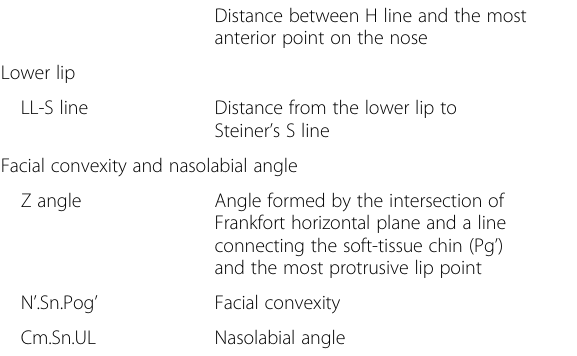
Table 1 Skeletal, dental and soft tissue cephalometric variables Maxillary skeletal components